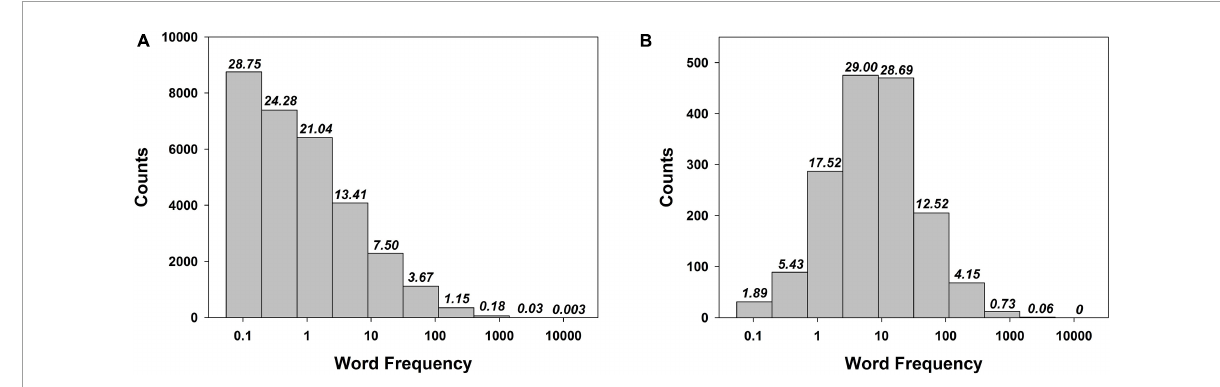
FIGURE2 Count of words per bin (and percentage out of a total per bin, italicized, on top of each bar): for all English nouns in the CELEX 2 database (A) vs. for the words used by Lohnas and Kahana (2013) in their experiment (B) . Note the massive shape difference between the two distributions. The abscissa represents occurrences of a word per one million words (log